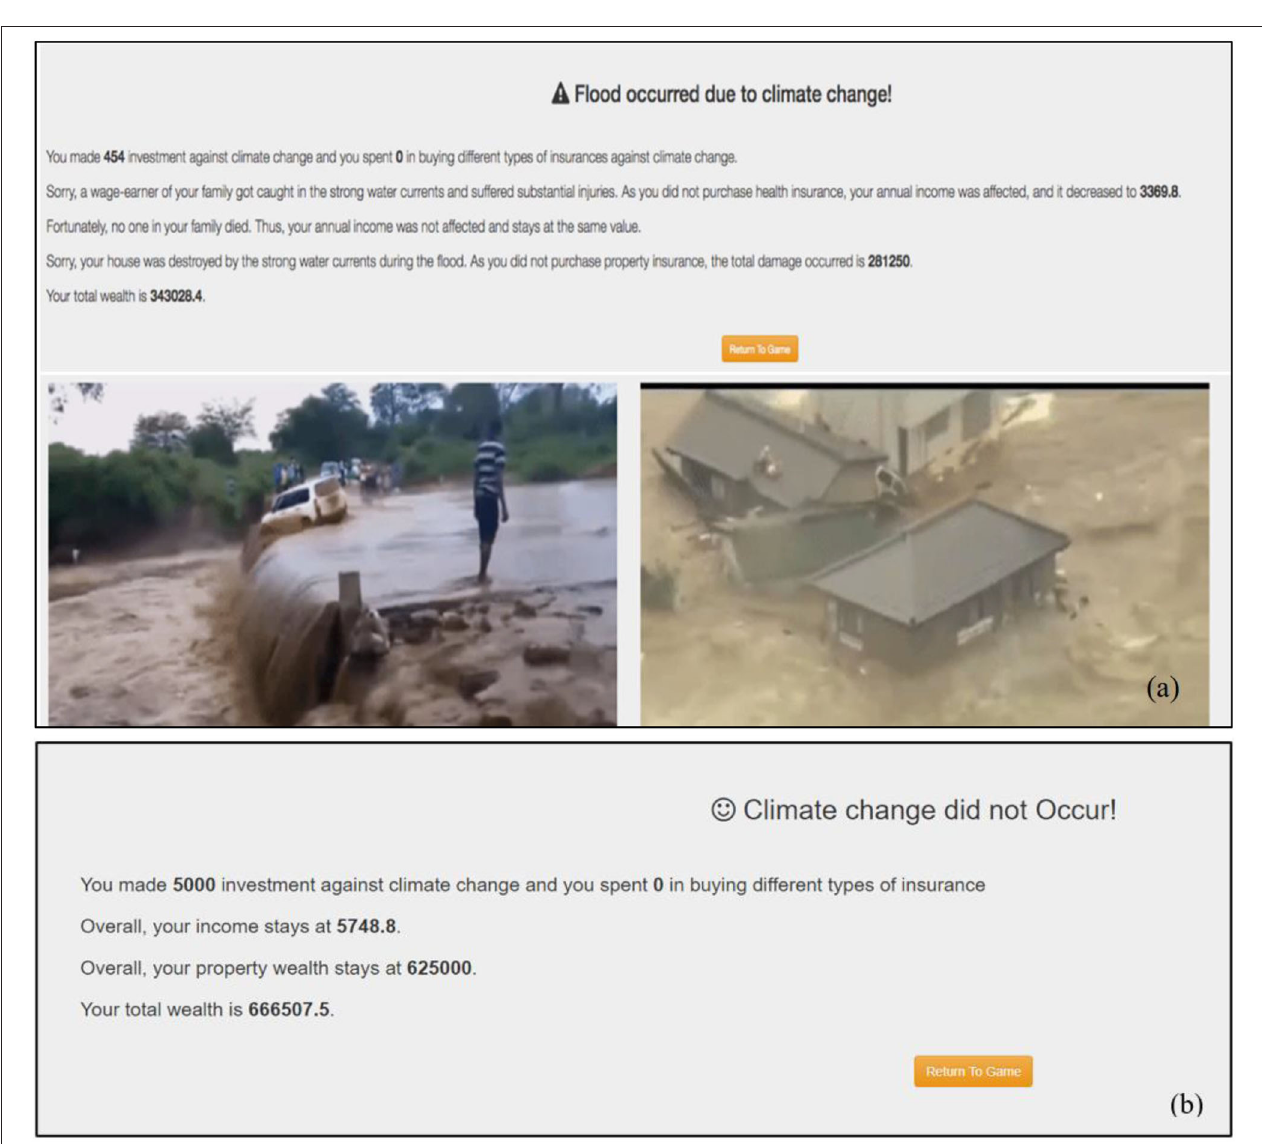
FIGURE 2 | Feedback screens. (a) Negative feedback screen, which informs participants about the losses incurred due to climatic disasters. (b) Positive feedback screen, which informs participants that climatic disasters did not occur.